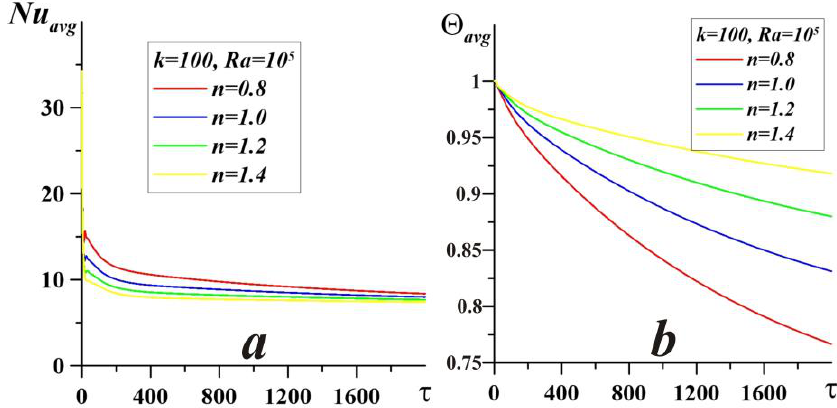
Figure 8. The time dependences of the average Nusselt number ( a ) and average heater temperature ( b ) at k = 100, Pr = 100, Ra = 10 5 and different n.